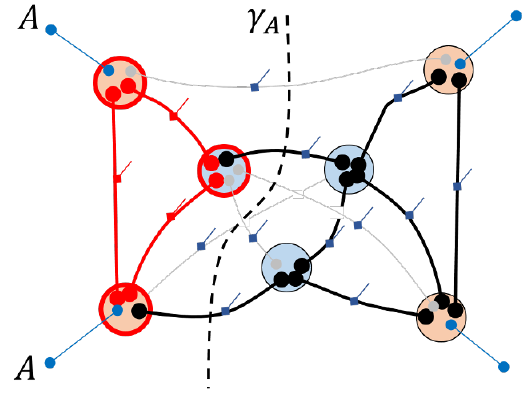
Figure 7 . Illustration of the entanglement wedge of a boundary region A . The vertices with red circles are the entanglement wedge E A , enclosed by A and the minimal surface (cid:13) A . The code subspace that can be locally reconstructed in region A are labeled by links with both ends in E A , marked by red bulk lines. (For clarity we have only drawn a few of the unconnected (grey)